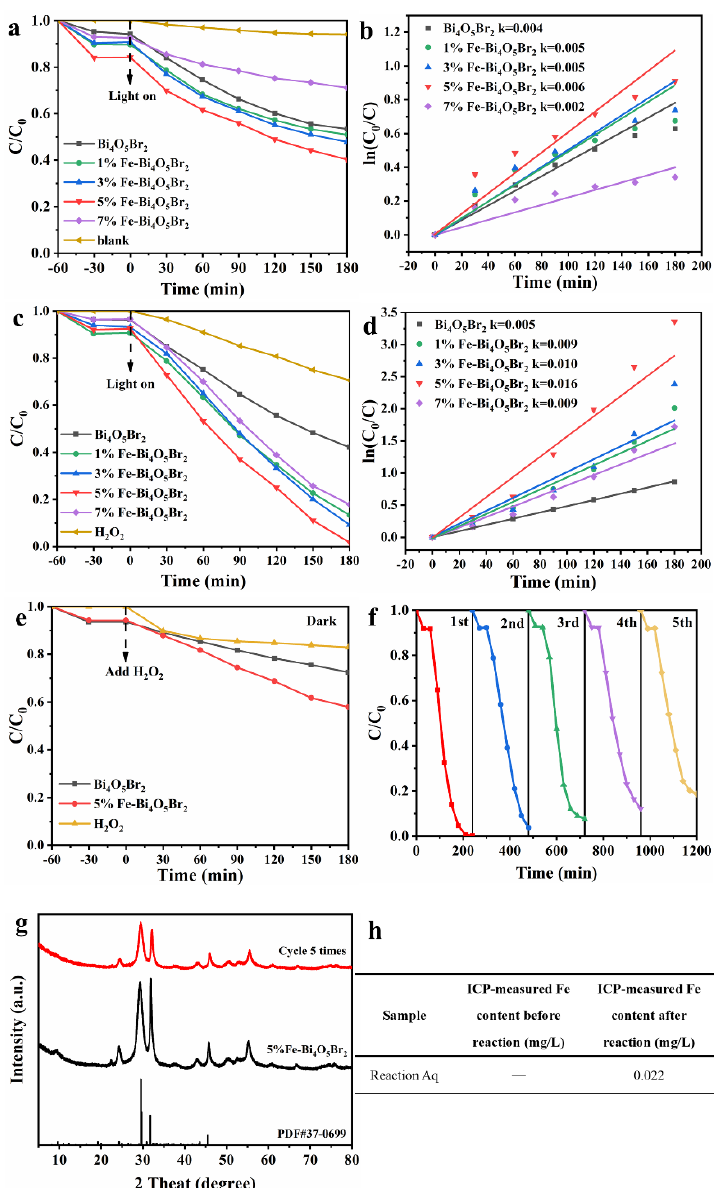
Figure 7. ( a ) Photocatalytic activity for the degradation of TC for samples, ( b ) The reaction kinetics of samples for the degradation of TC, ( c ) Photocatalytic activity for the degradation of TC for samples with H 2 O 2 , ( d ) The reaction kinetics of samples for the degradation of TC with H 2 O 2 , ( e ) The degradation of TC over samples under darkness, ( f ) Cyclic experiments of 5%Fe-Bi 4 O 5 Br 2 for the degradation of TC, ( g ) XRD patterns of 5%Fe-Bi 4 O 5 Br 2 before and after five cycles of reaction and ( h ) The Fe content of the solution before and after the photo − Fenton reaction by ICP-MS.